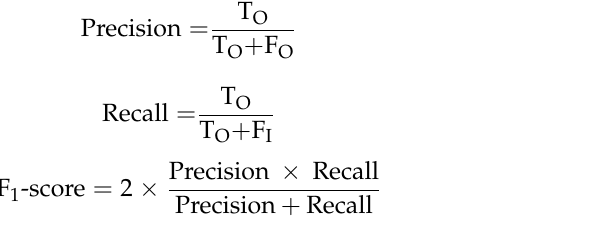
Figure 9. Pre-trained vs. the network trained on the plant data loss in 200 epochs (the number of iterations).